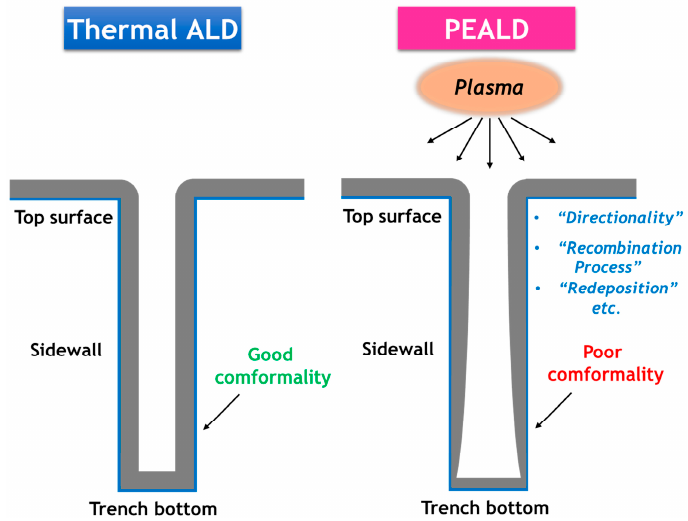
Figure 4. Schematic diagram of conformality degradation in PEALD, in comparison with thermal ALD.